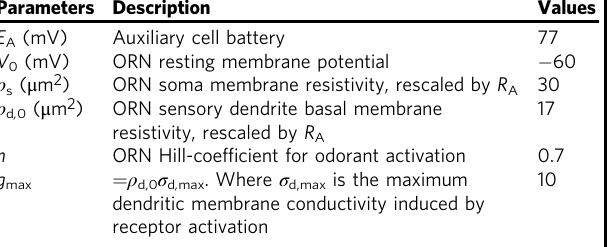
Table 3 Common parameters Parameters Description